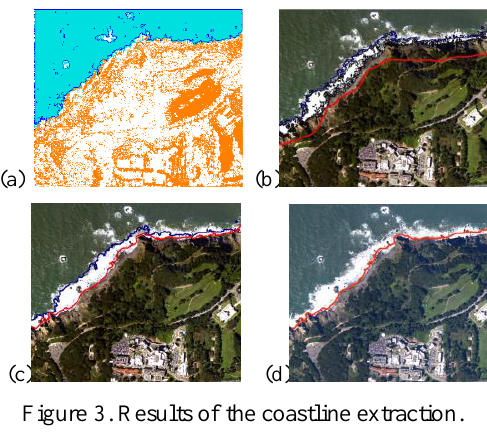
Figure 3. Results of the coastline